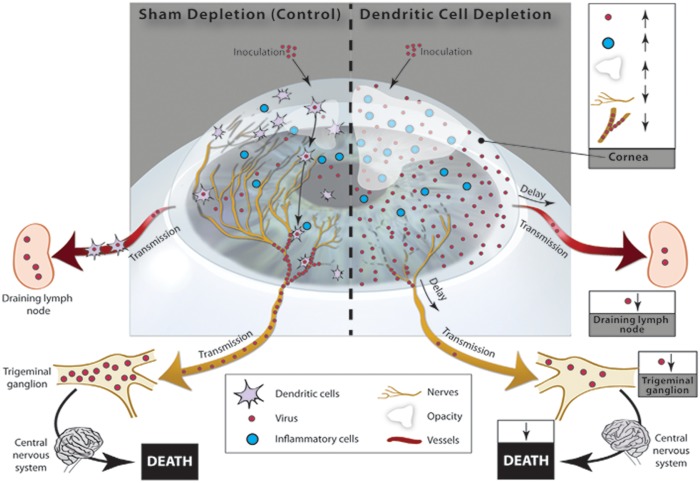
Corneal conventional dendritic cells play a pivotal role in the defense against HSV-1 virus, by reducing local corneal damage and preserving vision, at the cost of mediating systemic viral transmission.HSV-infected corneas demonstrate local viral replication, increased inflammatory cell infiltration, and corneal nerve damage, resulting in keratitis and corneal scarring. Infection of corneal nerves by HSV-1 may directly or indirectly be mediated through cDCs, resulting in transmission of the virus to the systemic compartment, including TGs, dLNs and the CNS, resulting in latency, or death. However, depletion of corneal cDCs results in increased viral proliferation, corneal inflammatory cells infiltration, nerve damage, and increased keratitis severity, scarring and blindness. Further, there are decreased corneal nerves infection, resulting in delayed and decreased systemic viral transmission to TGs and dLNs, and subsequent decrease in mortality. Collectively, corneal cDCs reduce local corneal damages and preserve vision after HSV infection, at the cost of mediating systemic viral systemic transmission resulting in death.